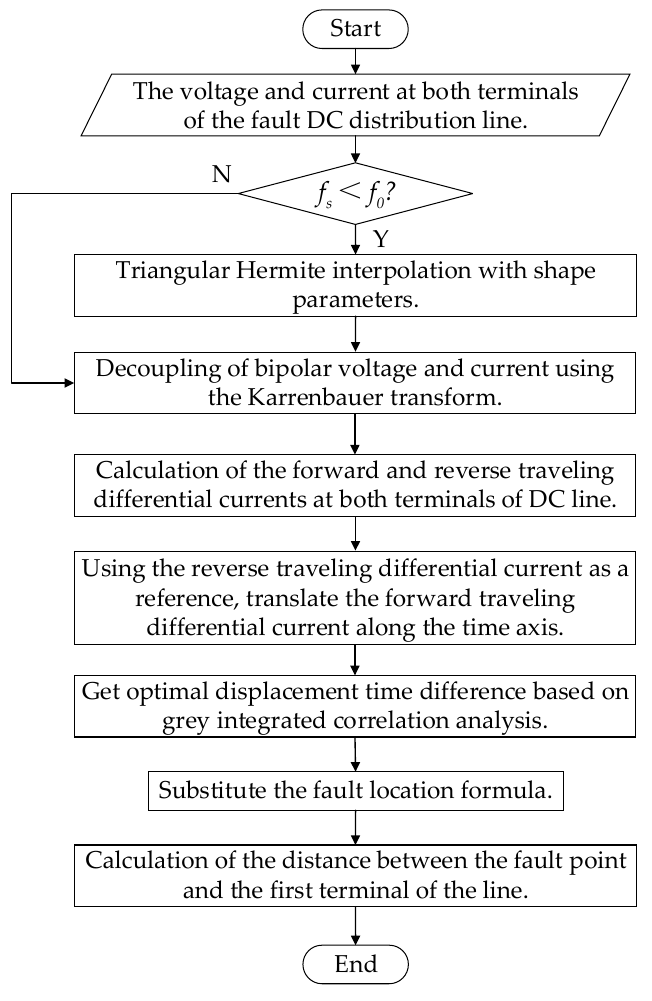
Figure 2. Flow chart of the fault location method. Within the scope of values of ∆ τ in Equation (3), it is known that the window length of post-fault data to be extracted by this algorithm is at least 2 τ 1 , and the formula for τ 1 is: